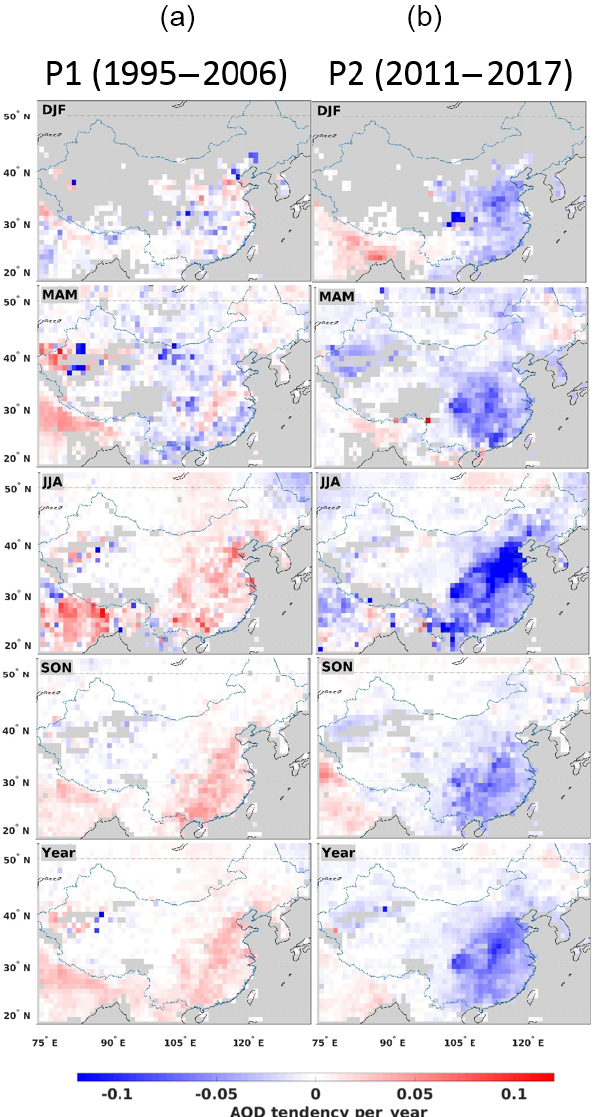
Figure 7. AOD tendencies (per year, see color bar) from seasonally and annually aggregated combined AOD time series for two peri- ods: 1995–2006 (P1, a ) and 2011–2017 (P2, b ).